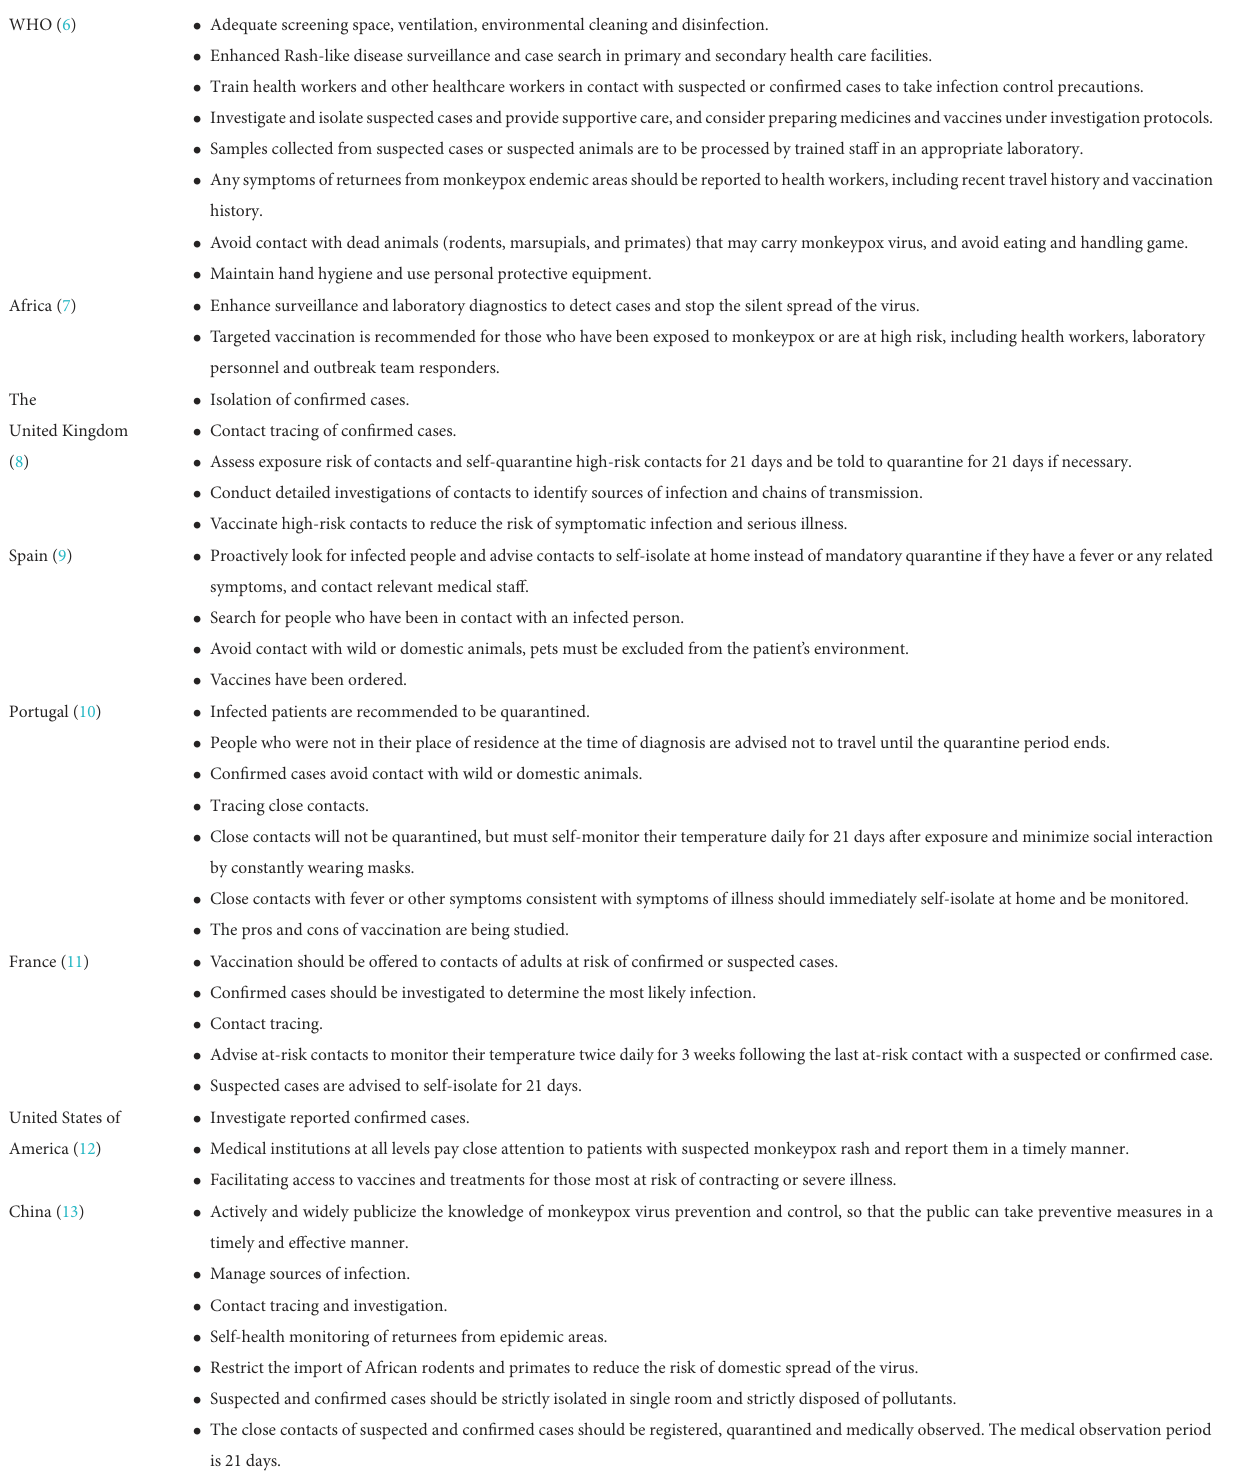
TABLE 3 Public health advice/management by